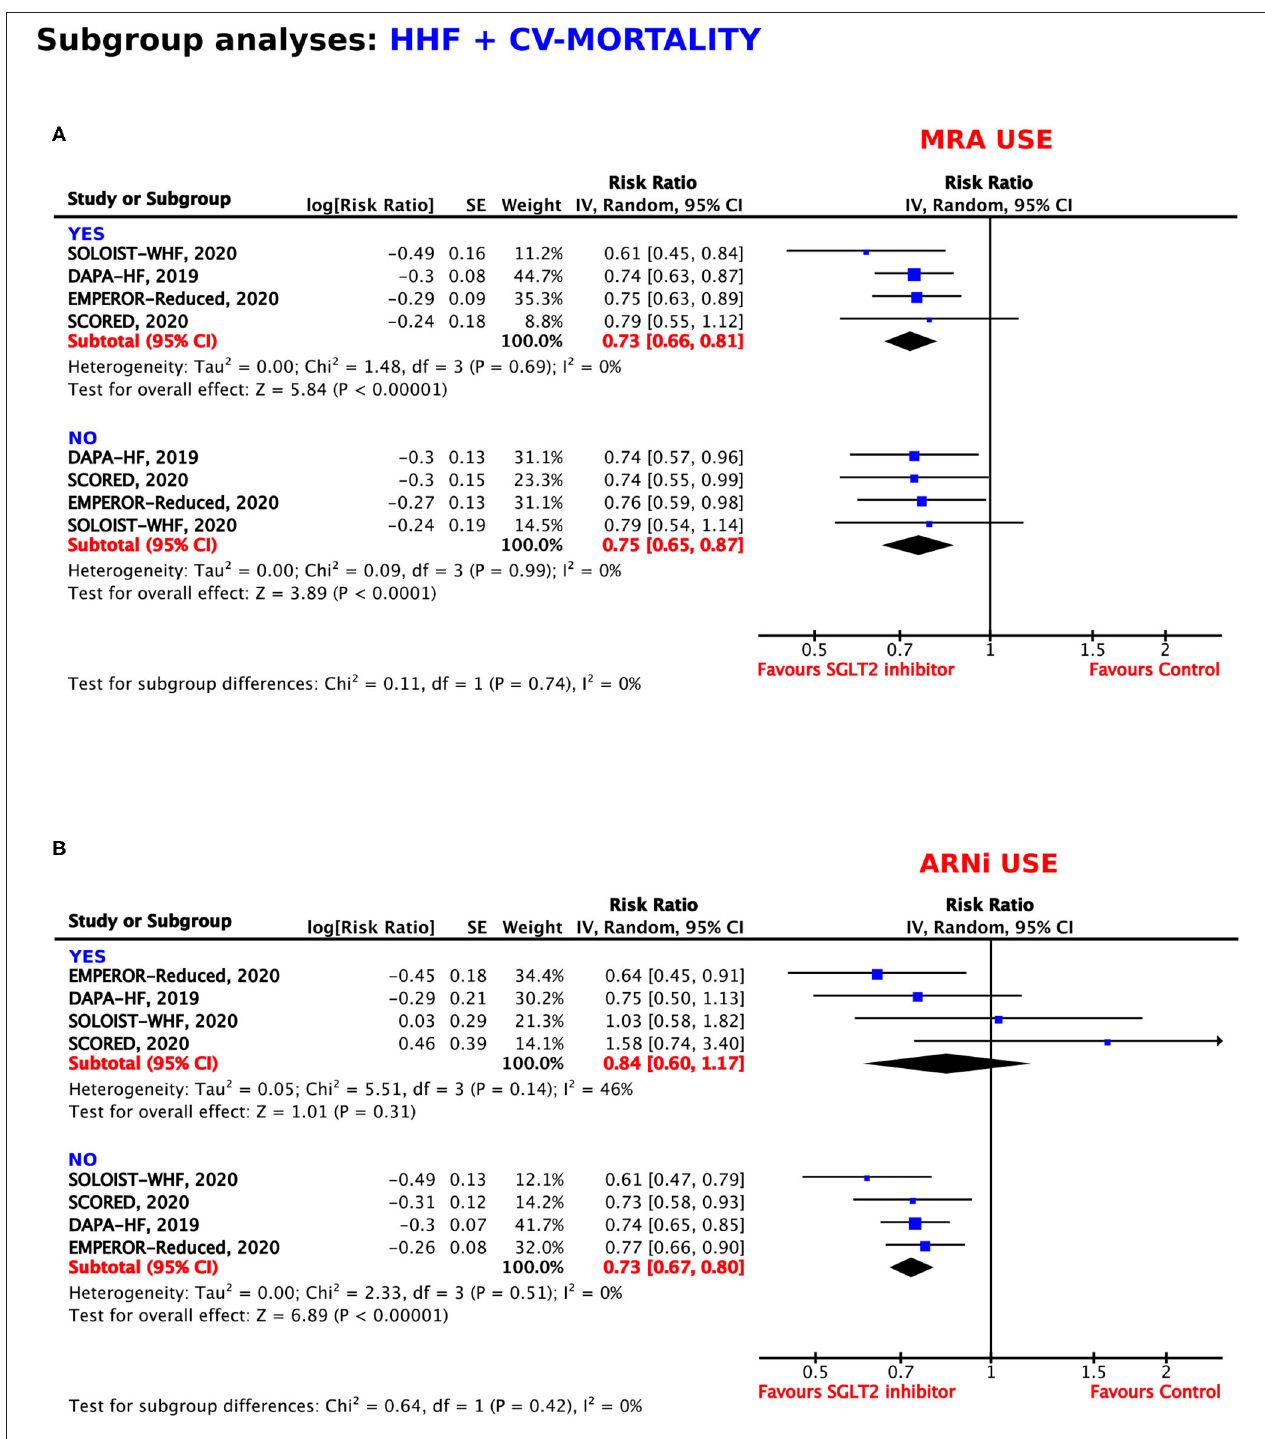
FIGURE 7 | Subgroup analyses for the composite outcome according to concomitant use of (A) mineralocorticoid receptor antagonists (MRAs) and (B) angiotensin receptor neprilysin inhibitors (ARNIs).